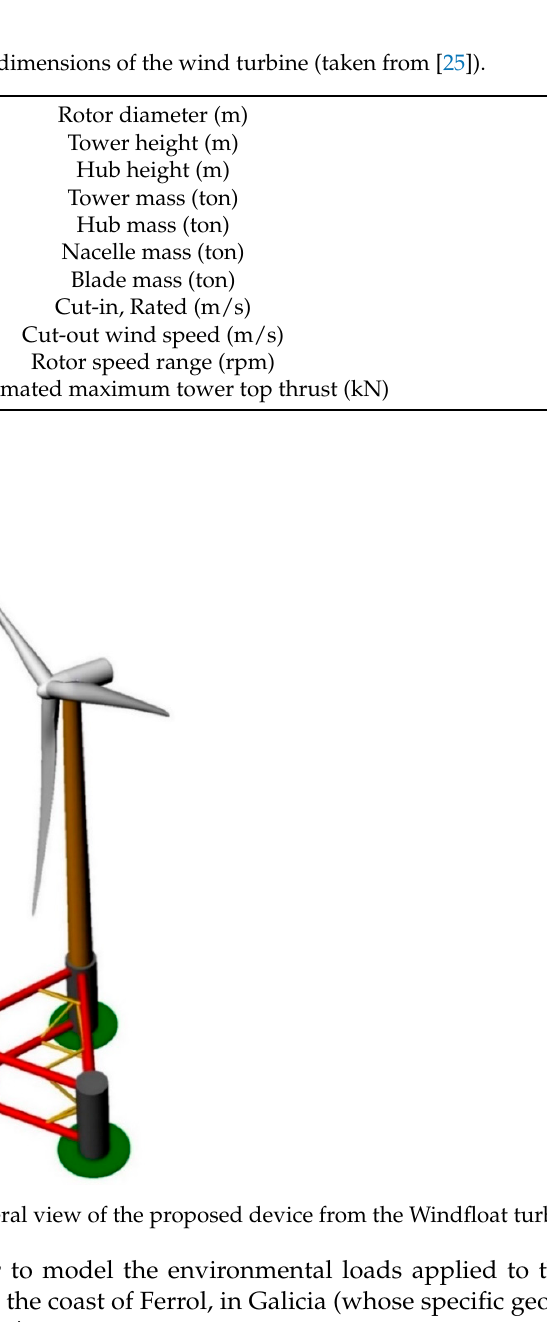
Table 1. Main dimensions of the floating platform under study (taken from [22]).